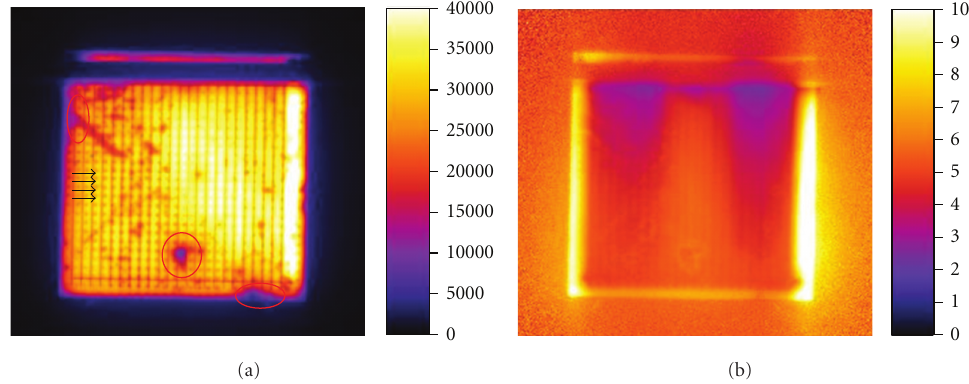
Figure 4: (a) Open-circuit PL image of a PERC cell made using EN and LIP Cu. The brighter the area, the higher the voltage in that location. The arrows highlight the locations of some of the rear point contacts, red circles are locations of shunts; (b) series resistance PL image of the same cell, bias voltage is − 300 mV.